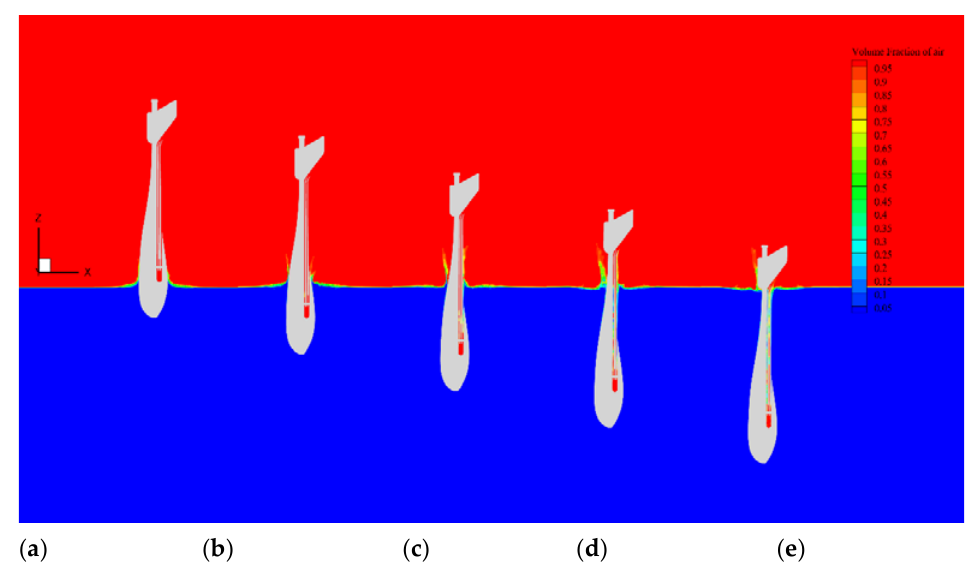
Figure 8. Free surface profiles of the vehicle entering water at W s = 4.0 m/s at different times: ( a ) t = 0.10 s, ( b ) t = 0.15 s, ( c ) t = 0.20 s, ( d ) t = 0.25 s, and ( e ) t = 0.30 s.